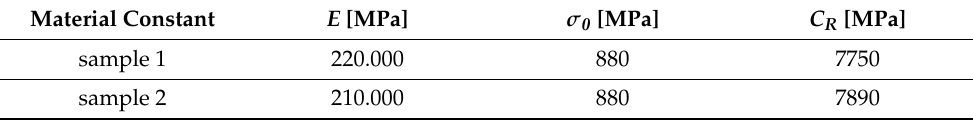
Table 3. Parameters of the material